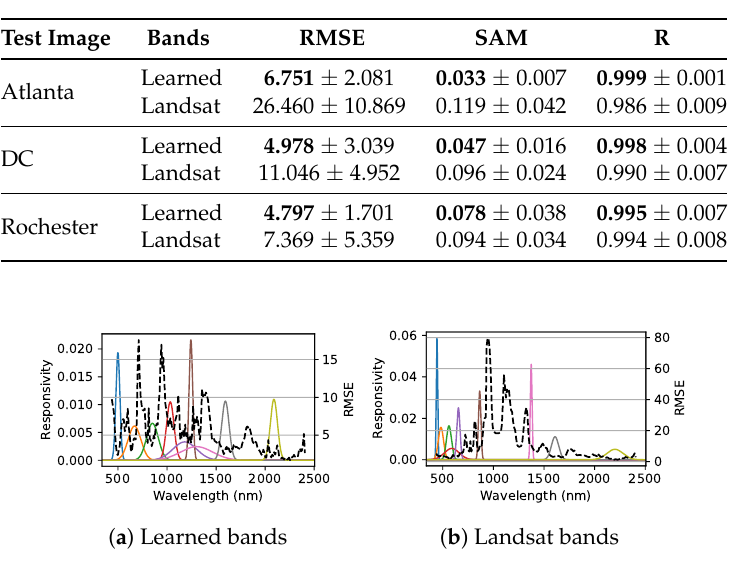
Figure 9. Responsivity of multispectral bands obtained using the satellite images dataset and RMSE across reconstructed bands (dotted line).